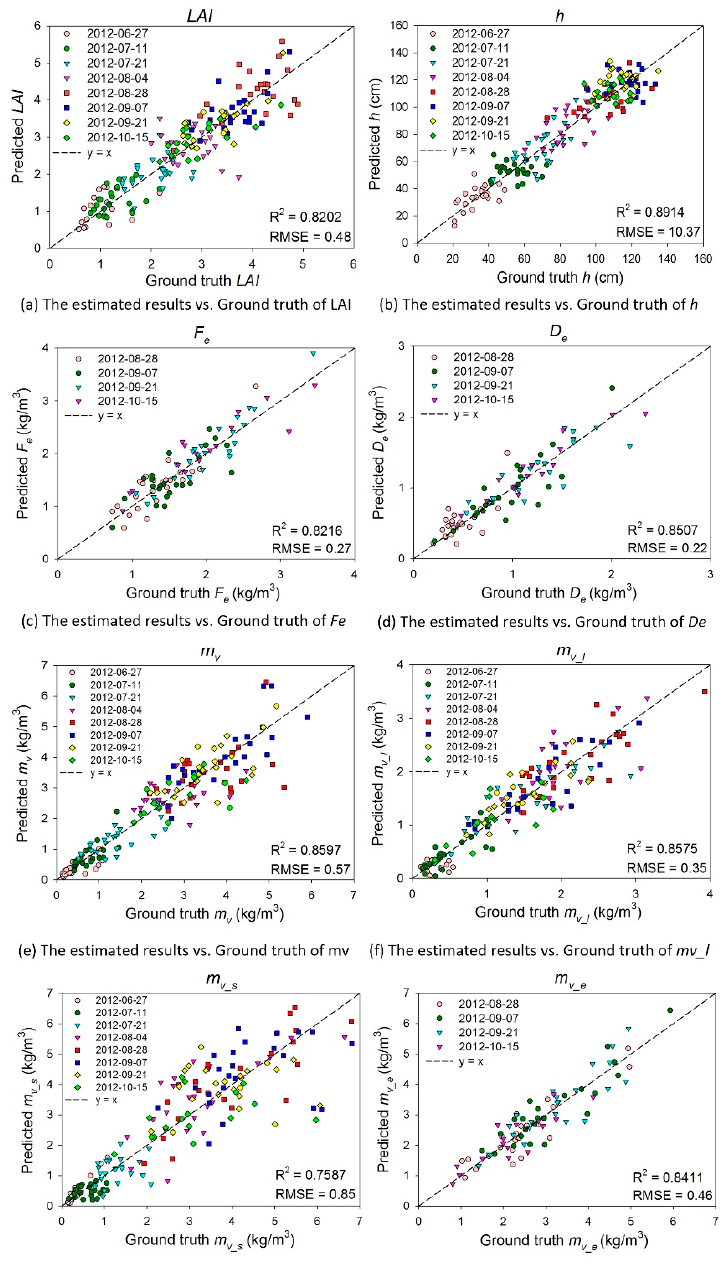
Figure 9. ( a – h ) The estimated results vs. ground truth data of the rice variables.